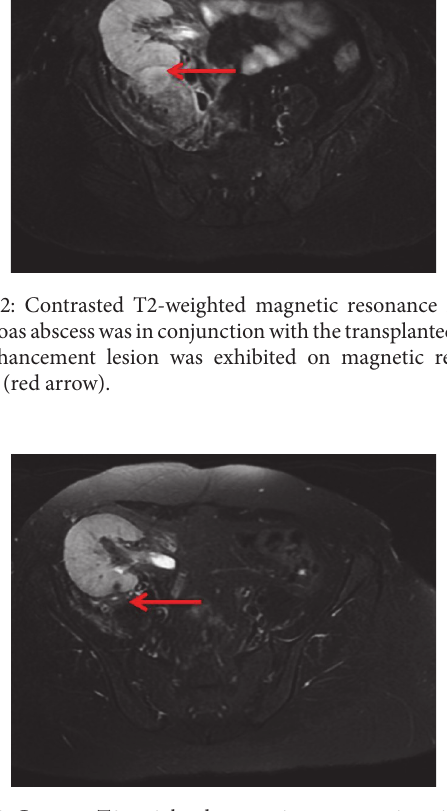
Figure 3: Contrast T2-weighted magnetic resonance imaging. After the patient was given antibiotics, right psoas abscess ameliorated within 2 months (red